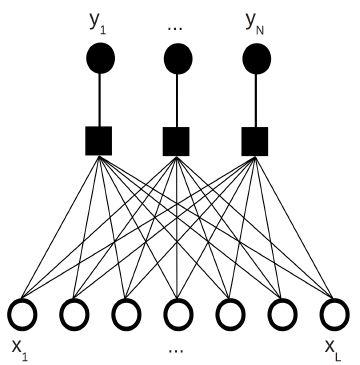
Figure 1: Factor graph that correspond to Eq. 3. Empty circles depict variables x , i ∈ [ L ] and squares are representatives of i factors. Filled circles represent the observations y structure of Eq. 4 is obviously represented by this bipartite